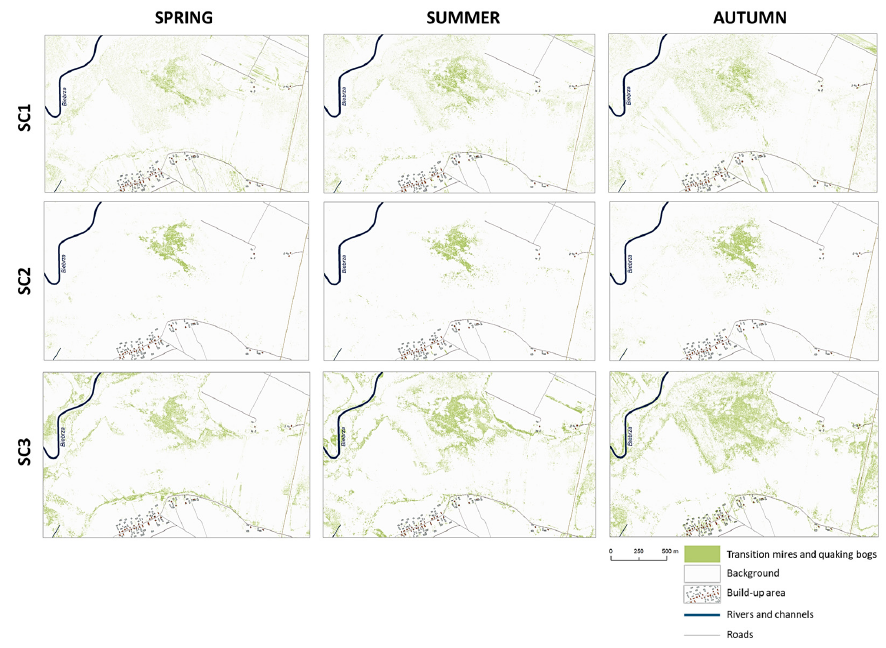
Figure 7. An Example of comparison of classification results for transition mires and quaking bogs in the UB area in spring, summer, and autumn campaigns for three scenarios in level 1 (SC1, SC2, and SC3).